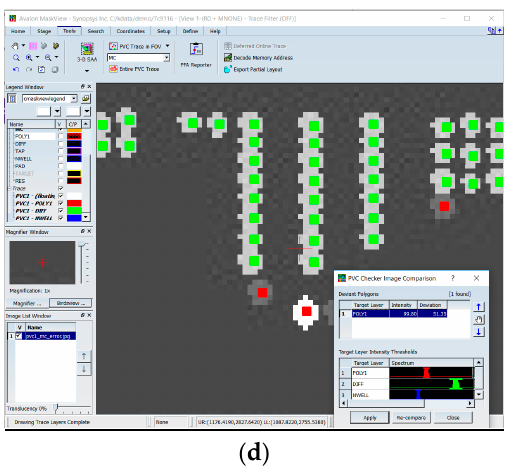
Figure 20. Use flow of PVC checker in Avalon Tool. ( a ) Load SEM Image Showing passive voltage contrast ( b ) Align Image to CAD ( c ) Setup PVC Checker ( d ) Analyzing results-finding the deviated polygons.